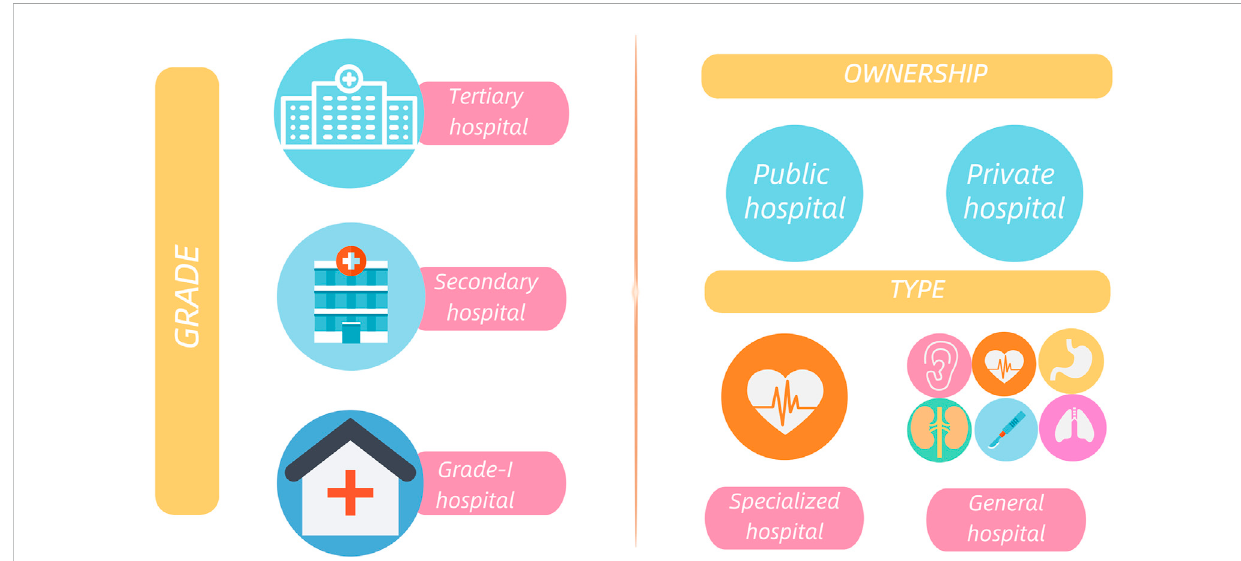
FIGURE 1 Thegrade,ownershipandtypeofhospitalsinChina,Gradeofhospitals:Accordingtothe HospitalGradingManagementStandard ,Chinesehospitals are divided into 3 grades, i.e., tertiary, secondary and grade-I hospitals, based on a series of indicators (hospital scale, research capabilities, medical facilities, etc. ). Among these grades, the tertiary hospital is the premier. Ownership of hospitals: Public hospitals are hospitals funded by the country and taken into the government ’ s fi nancial budget. Being the mainstay of Chinese medical service system, public hospitals are directly managed by local health authorities, emphasizing public welfare. Private hospitals refer to health institutions funded by societies and dominated by for-pro fi t institutions. The establishment of private hospitals must be approved by local health authorities. Type of hospitals: includes general and specialized